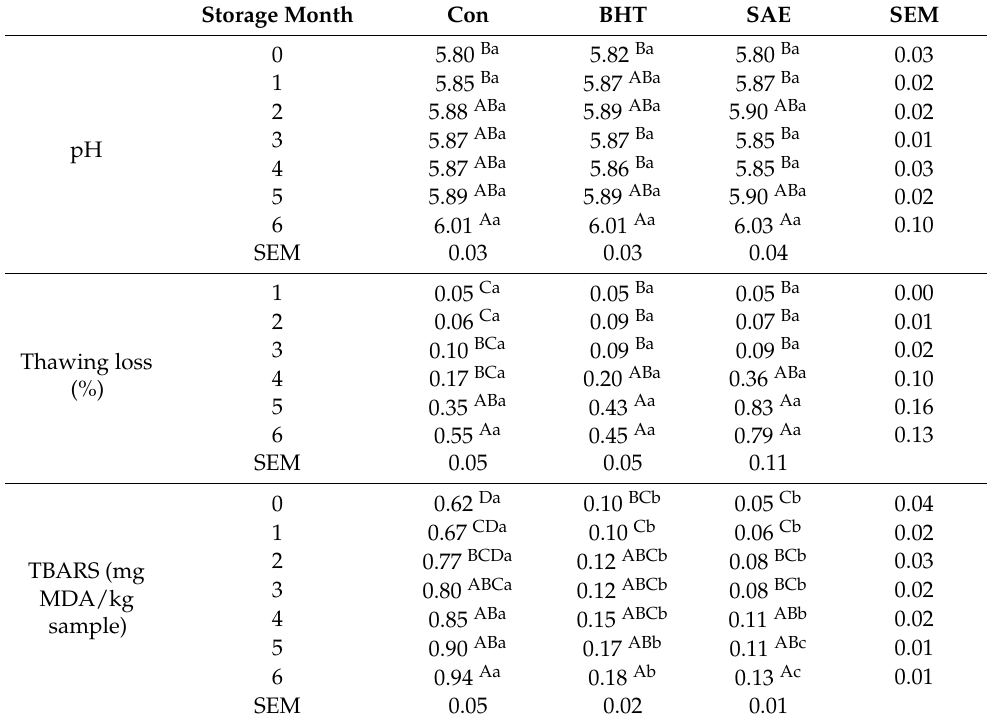
Table 1. The pH, thawing loss, and TBARS values of cooked ground beef with different antioxidant additives at frozen